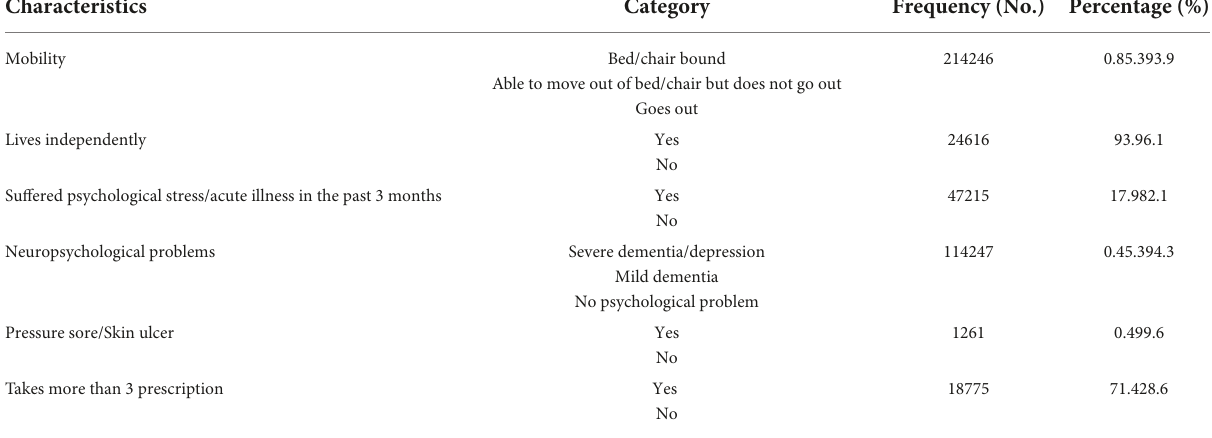
TABLE 5 General assessment of older adult patients with heart failure at Cardiac Clinic, University of Gondar hospital, June 01, 2021 to October 31, 2021 (No. 262). Characteristics